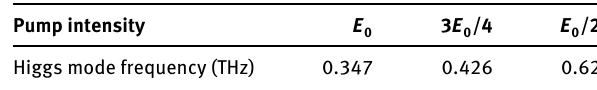
Table 1: Extracted Higgs mode frequencies under different THz pump